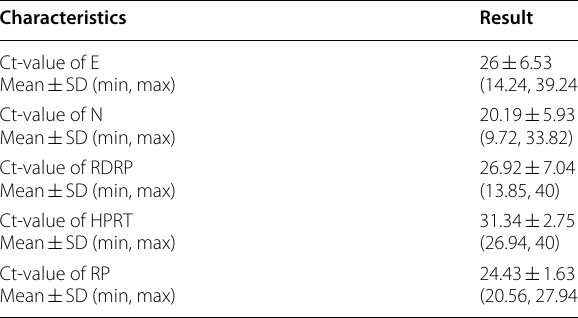
Table 2 The Ct value emerged in RT‑PCR assay for the SARS‑